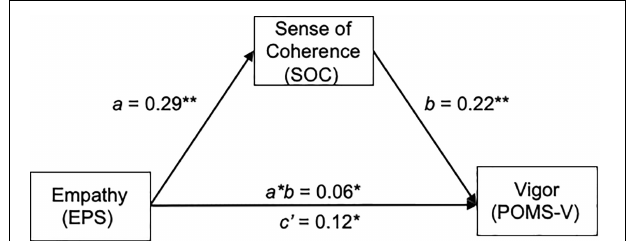
FIGURE 2 | Mediation effect of SOC on the relationship between empathy and self-vigor mood (POMS-V). EPS, empathy; SOC, sense of coherence; POMS-V, profile of mood state vigor.